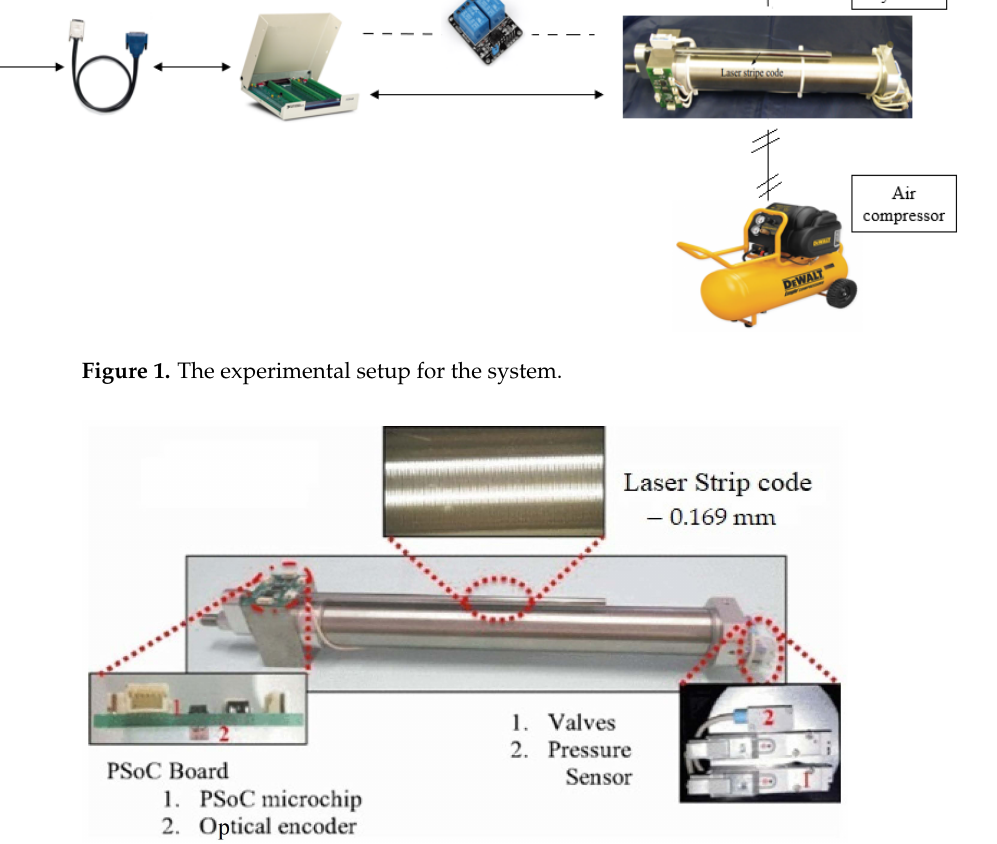
Figure 2. The pneumatic cylinder and its parts.